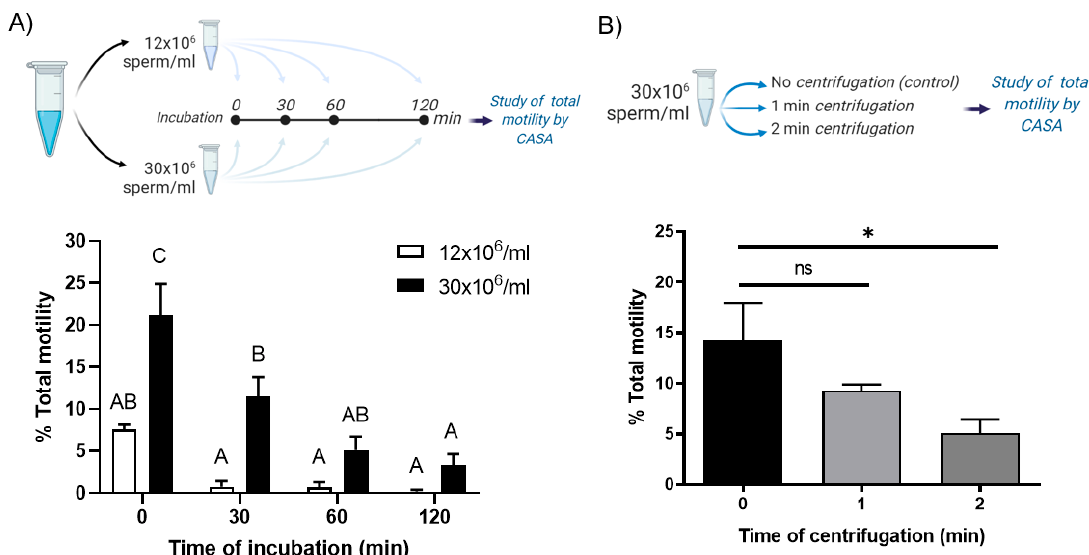
Figure 2. Parameters that affect cryopreserved equine sperm motility. ( A ) Time of incubation and sample concentration. Spermatozoa were incubated in NCWM at 12 × 10 6 /mL or at 30 × 10 6 /mL and motility was determined at different times (0, 30, 60 and 120 min). Two ‐ way ANOVA with repeated measures ( p < 0.05). n = 4. Means with different letters are significantly different (Tuckey post hoc test). ( B ) Time of centrifugation. Spermatozoa were incubated at 30 × 10 6 /mL centrifuged for 0 min (control), 1 min or 2 min at 200× g . One ‐ way ANOVA ( p < 0.05). ns: not statistically different. * Indicates statistically significant differences (Dunnett’s post hoc test between the mean of each time of centrifugation and control). n = 4. Bars represent the mean ± SEM of total motile sperm. Percentage of total motility was assessed by Computer Assisted Sperm Analysis (CASA).